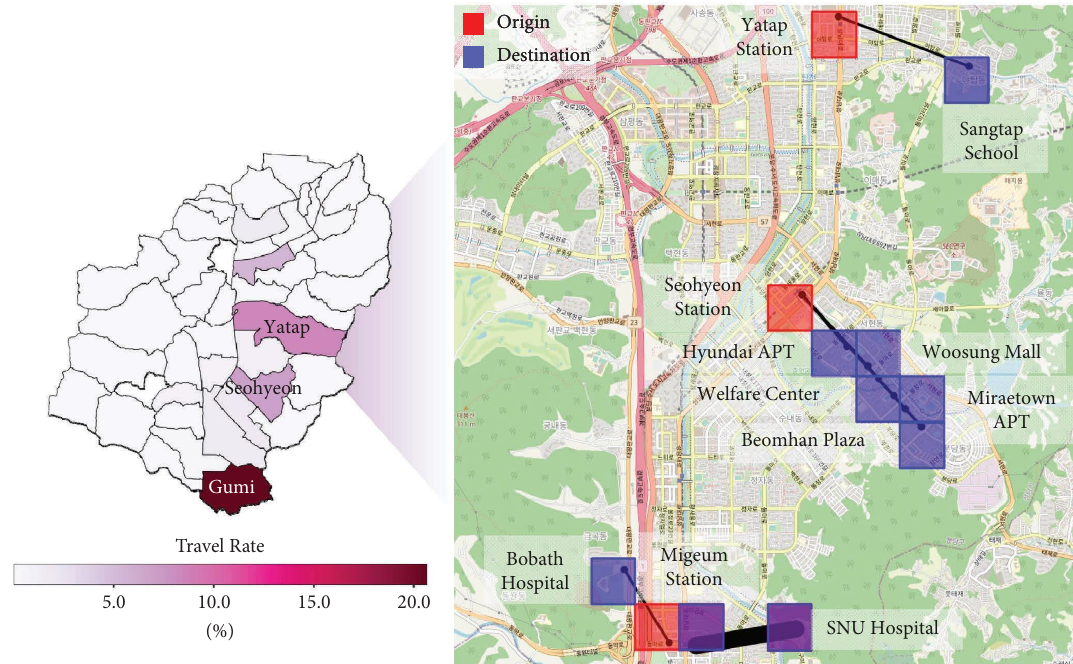
Figure 5: Top ten OD pairs of cluster 1.